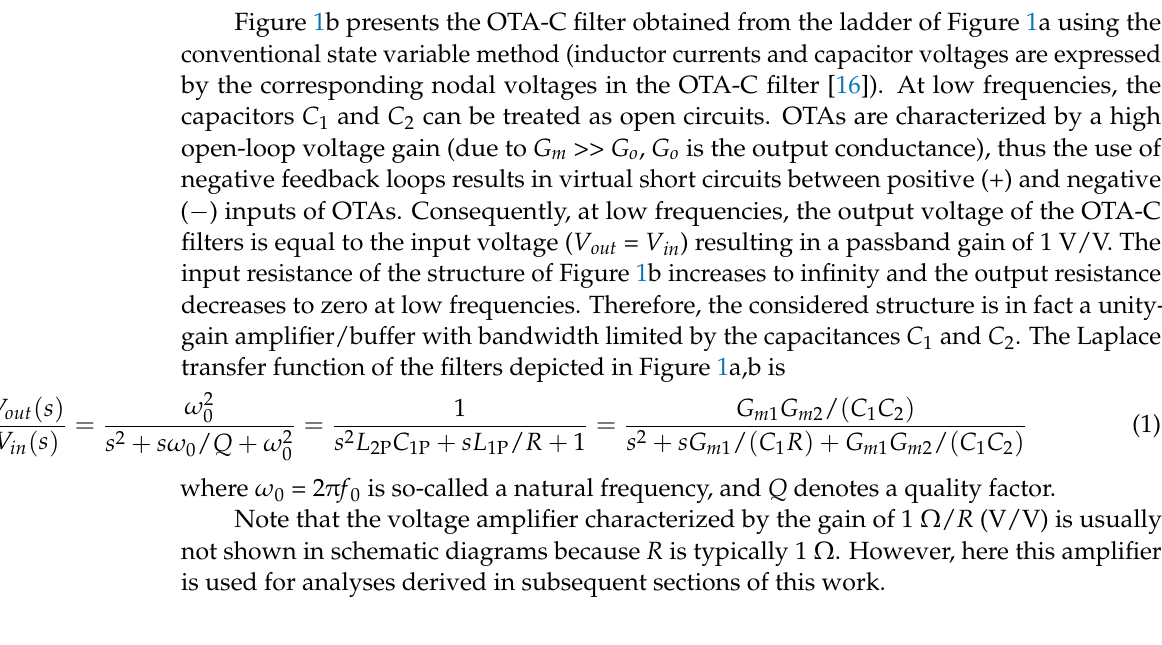
Figure 1. Second-order low-pass filter: ( a ) single-resistance terminated ladder prototype; ( b ) OTA- C (Gm-C) realization.